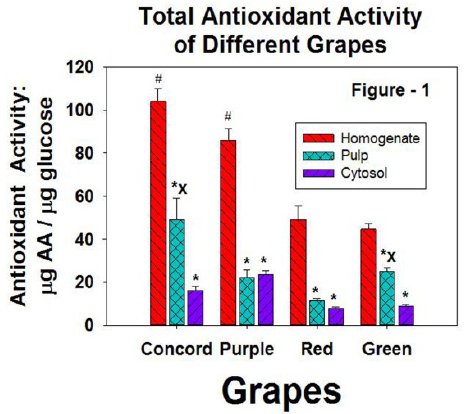
Figure 1. The antioxidant capacity of the homogenates (total antioxidant capacity of the grape), the pulp (a homogenate of the grape without the skin), and the cytosol (the clear supernatant after centrifugation). # = significantly higher than the antioxidant capacity of red and green grapes, p < 0.05. * = significantly lower antioxidant capacity of the homogenate, p < 0.05. x = significantly higher antioxidant capacity of the cytosol, p < 0.05.